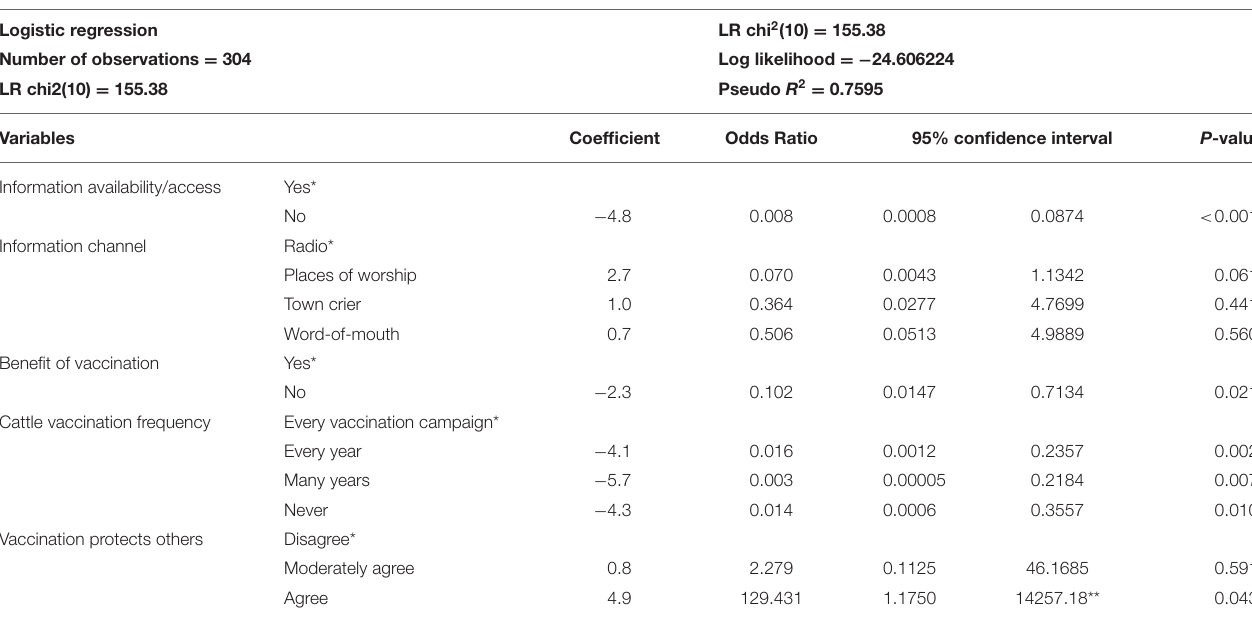
TABLE 3 | Factors associated with the WTV during vaccination